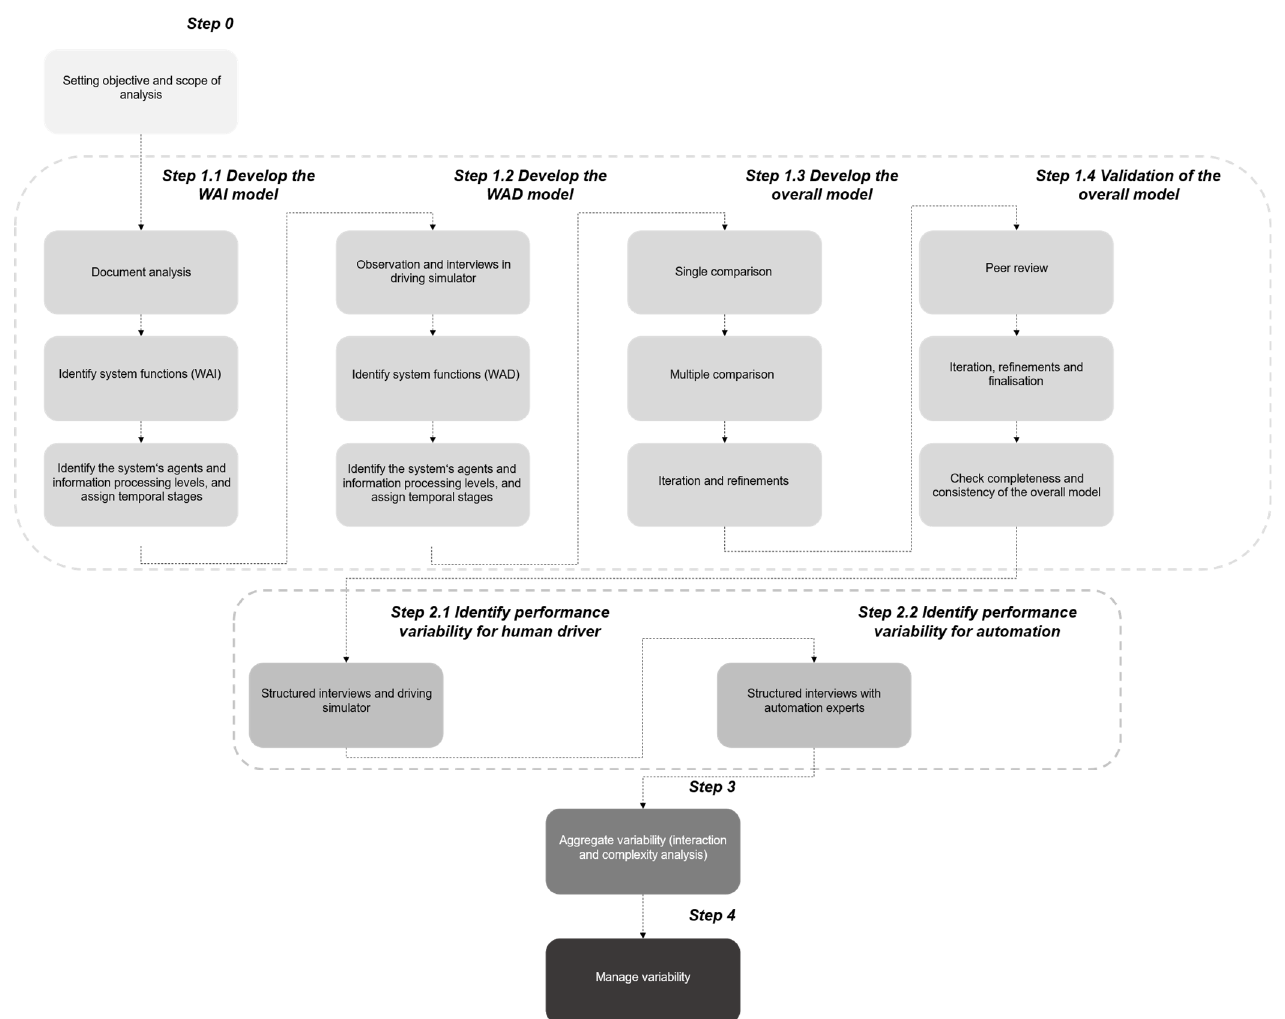
Figure 1. Methodological steps of the research method implemented in this